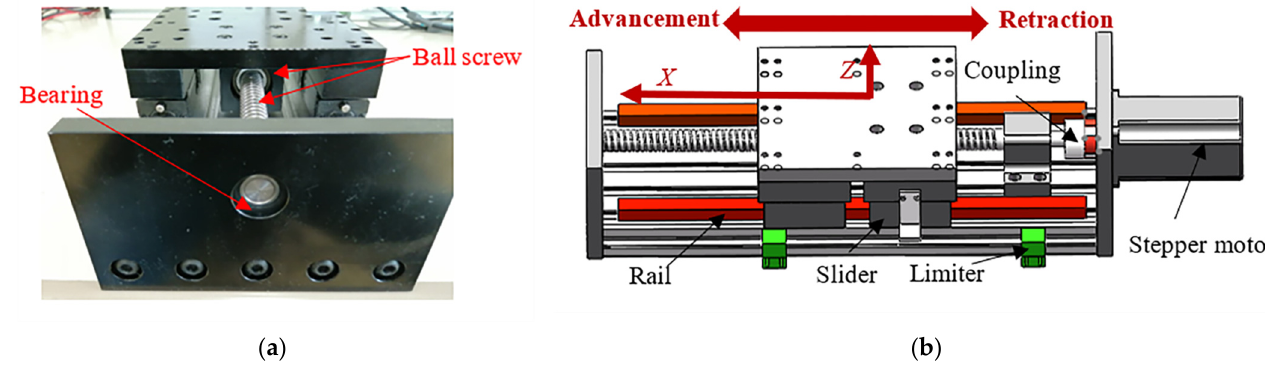
Figure 5. ( a ) Left view of the FP (physical picture); ( b ) front view of the FP (designed picture).